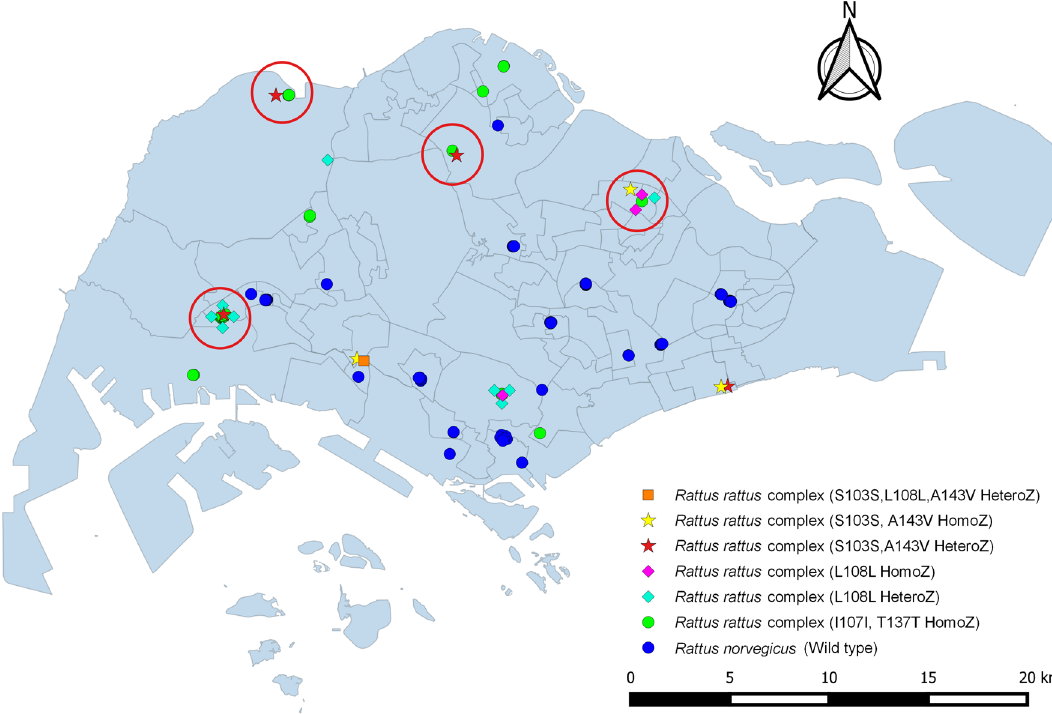
Figure 1. Map of Singapore depicting the locations of rats being sampled. Rats with the various SNPs are represented with different symbols and colours. Locations circled in red contains R. rattus complex samples with disparate types of mutations. Figure created with QGIS version 3.16.4-Hannover (https:// qgis. org/ downl